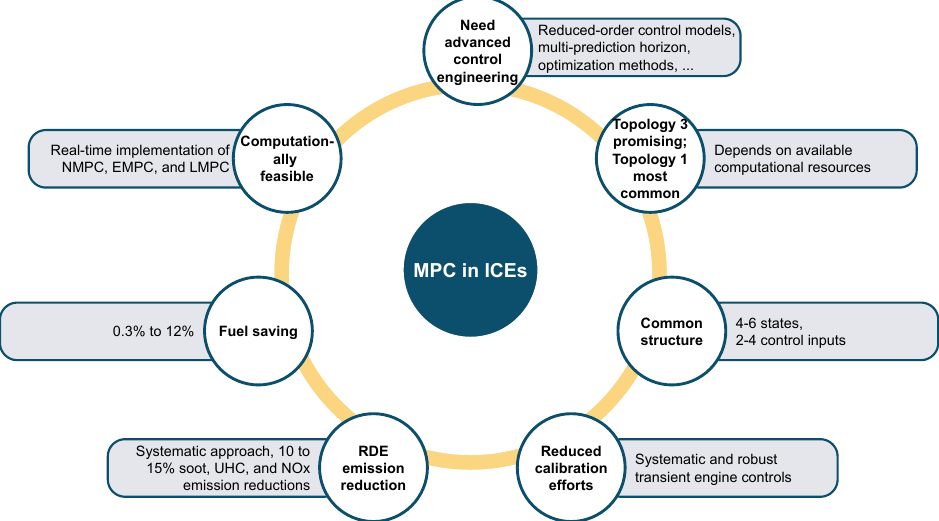
Figure 21. Promises of MPC for ICE control applications based on the studies in the